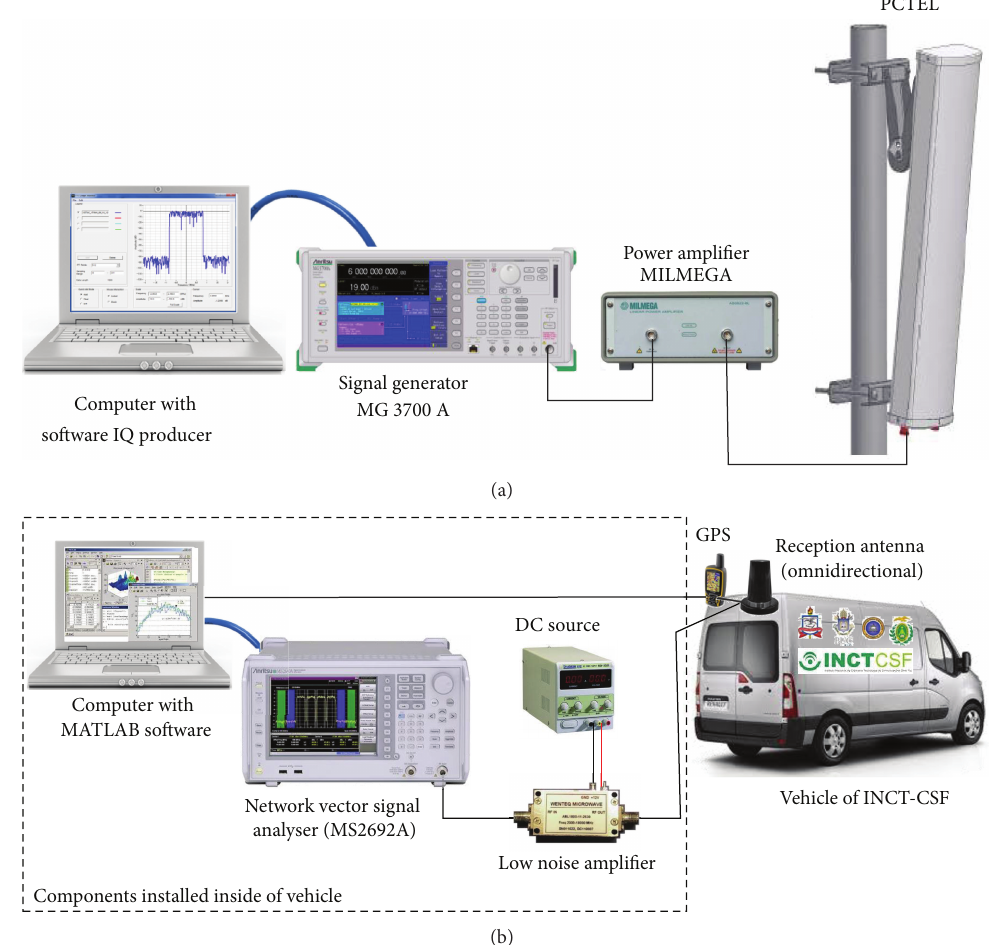
Figure 1: (a) Transmission setup; (b) reception setup.